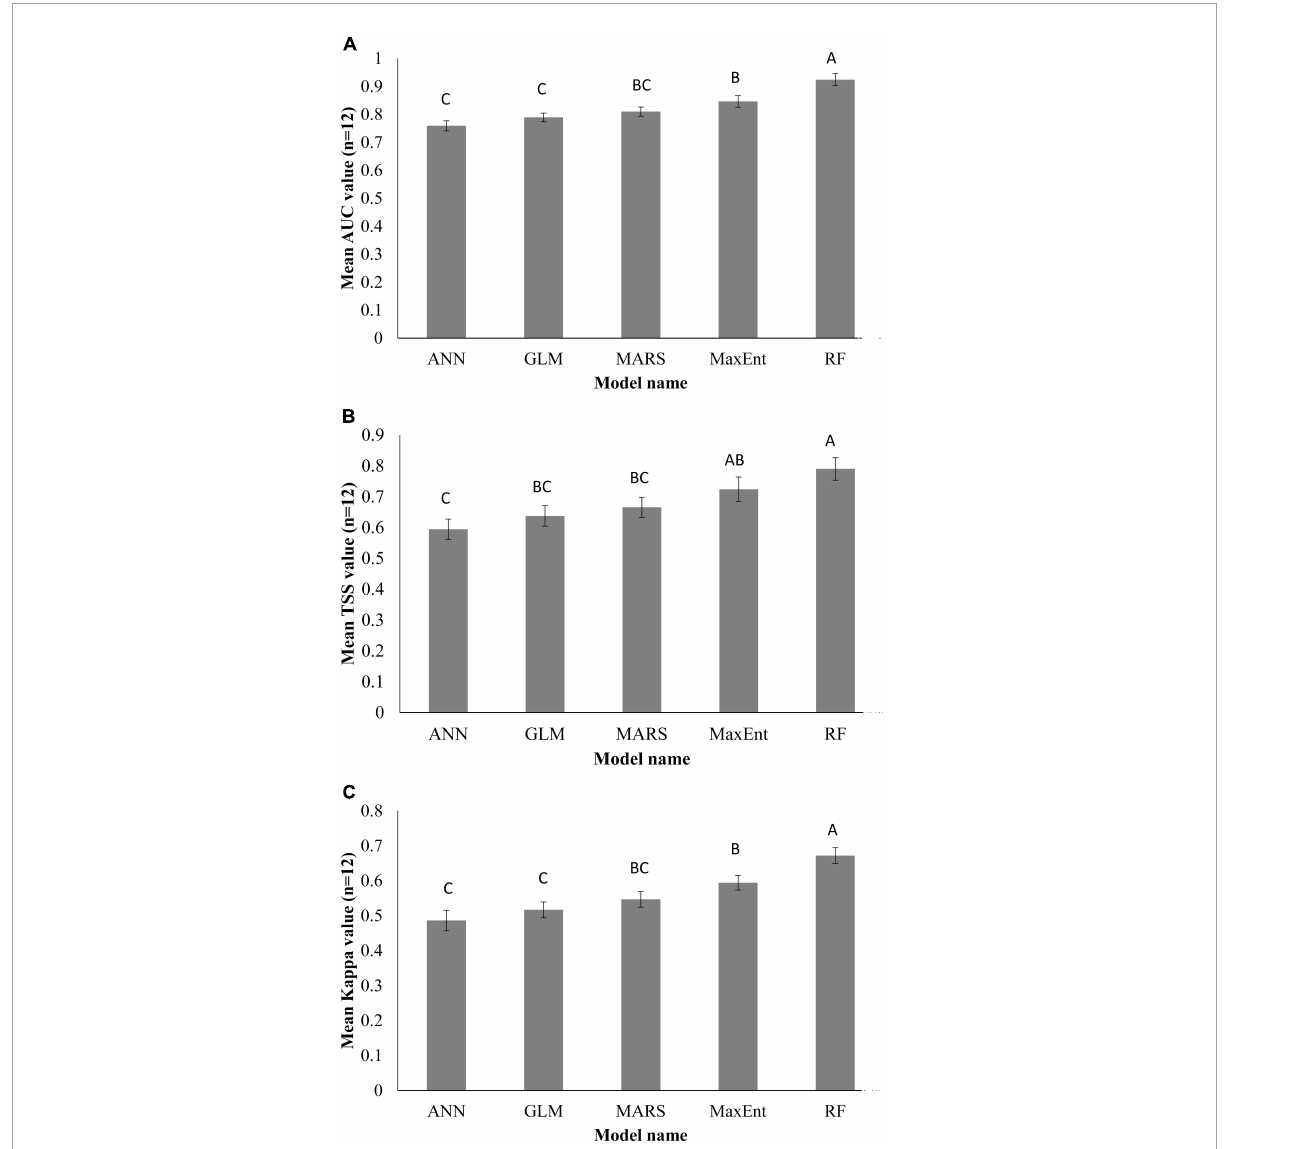
FIGURE3 Predictive performance of the SDMs used in this study. AUC (A) , TSS (B) , and Kappa (C) values of 12 EDAPS for calibrating the five SDMs. Values are means ( n = 12) ± standard error. Similar letters above the bar graphs indicate no significant differences among the models based on Duncan’s multiple range test.